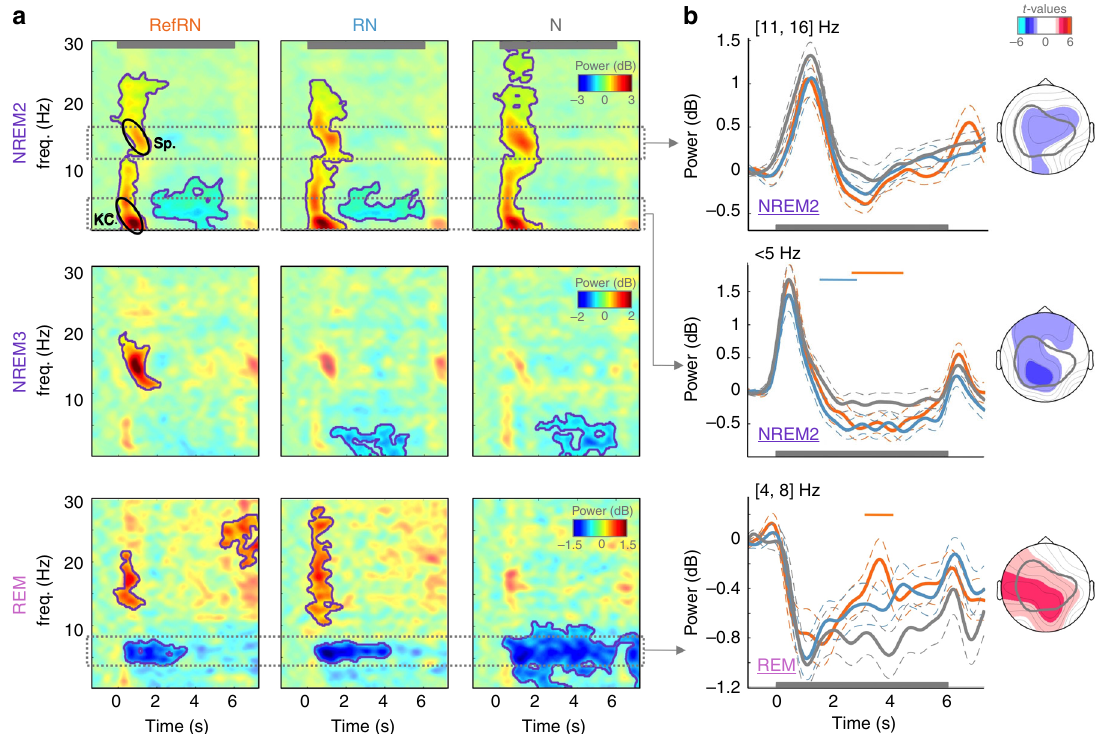
Fig. 5 Stimulus-dependent modulations of sleep rhythms. a Time – frequency decomposition of the EEG signal recorded on Cz in response to RefRN ( left ), RN ( middle ), and N ( right ) trials in NREM2 ( top ), NREM3 ( middle ), and REM ( bottom ) sleep stages. Power is time-locked to stimulus onsets, averaged across participants ( N = 20) and expressed in dB compared to a pre-stimulus baseline ([ − 0.25, 0]s, see Methods). Magenta contours correspond to signi fi cant modulations compared to baseline activity (cluster permutation, P cluster < 0.05). Gray horizontal bar shows the stimulus presentation window. b Average activity in time – frequency bands typically associated to NREM ( δ -power, < 5 Hz (corresponding to evoked KC: K-complexes,); σ -power, [11, 16] Hz (corresponding to Sp.: sleep spindles)) and REM rhythms ( θ : [4, 8] Hz). The power responses were averaged over these frequency bands for NREM2 ( top : σ , middle : δ ) and REM sleep ( bottom : θ ). Between-condition differences are illustrated with colored horizontal bars (cluster-permutation test, P cluster < 0.05, orange : RefRN vs. N, blue: RN vs. N). Gray horizontal bar shows the stimulus presentation window and dotted lines denote the standard error of the mean computed across participants ( N = 20). When comparing RefRN and N trials, NREM2 was characterized by a decrease in δ power, REM by an increase in θ power for RefRN trials. Note the tendency for a decrease in power in the σ band for RefRN compared to N trials, although such a decrease did not resist the cluster permutation (no cluster with P cluster < 0.05). The scalp distribution of the t-values of the RefRN vs. N comparison when averaging the power in the corresponding frequency band and over a [0.8, 5.5] s window is displayed on the side. The gray contour shows the scalp distribution of the MEPs observed in wakefulness (Fig. 2b). Note the overlap between the scalp distributions of the effects observed in